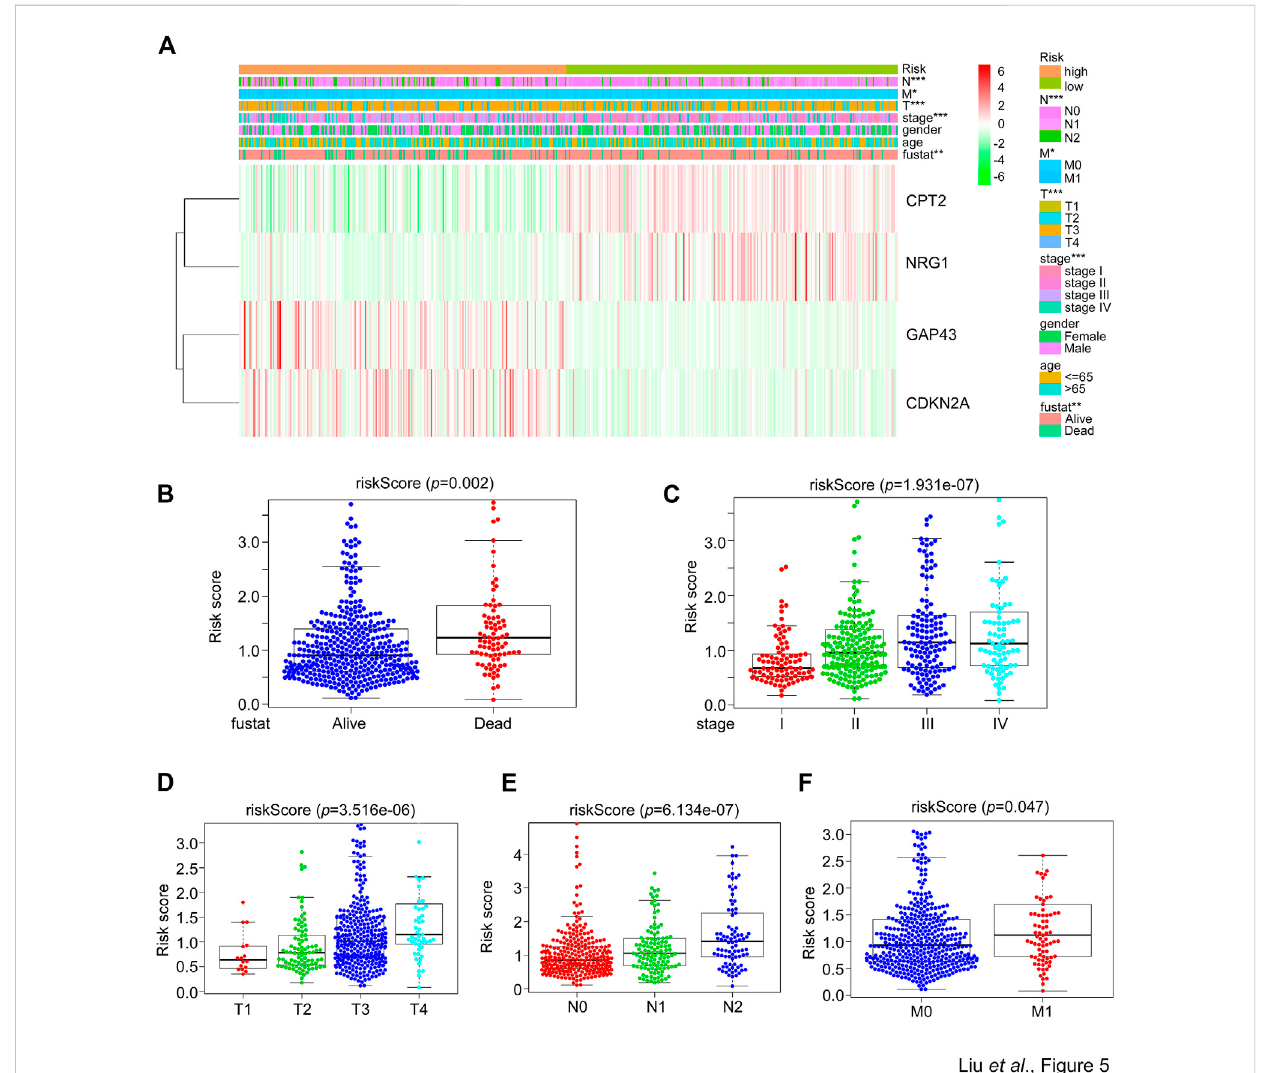
FIGURE 5 ThecorrelationbetweentheSGPPGSandclinicalfeaturesintheTCGAcohort. (A) ThemRNAlevelsofCPT2,NRG1,GAP43,andCDKN2Aandclinical pathology factors between high or low-risk groups calculated by the risk score formula from the whole TCGA-CRC cohort were used to generate a heatmapingroupsoftumorandnormaltissues.Chi-squaretestwasusedforthecomparisons. (B – F) TheTCGA-CRCdatasetwasusedtoanalyzetherisk score obtained from (A) in (B) alive and dead status of patients ’ tissues, and in (C) stage or (D – F) T (size and extent of main/primary tumor) N (lymph node metastasis) M (distant metastasis) related CRC tumor